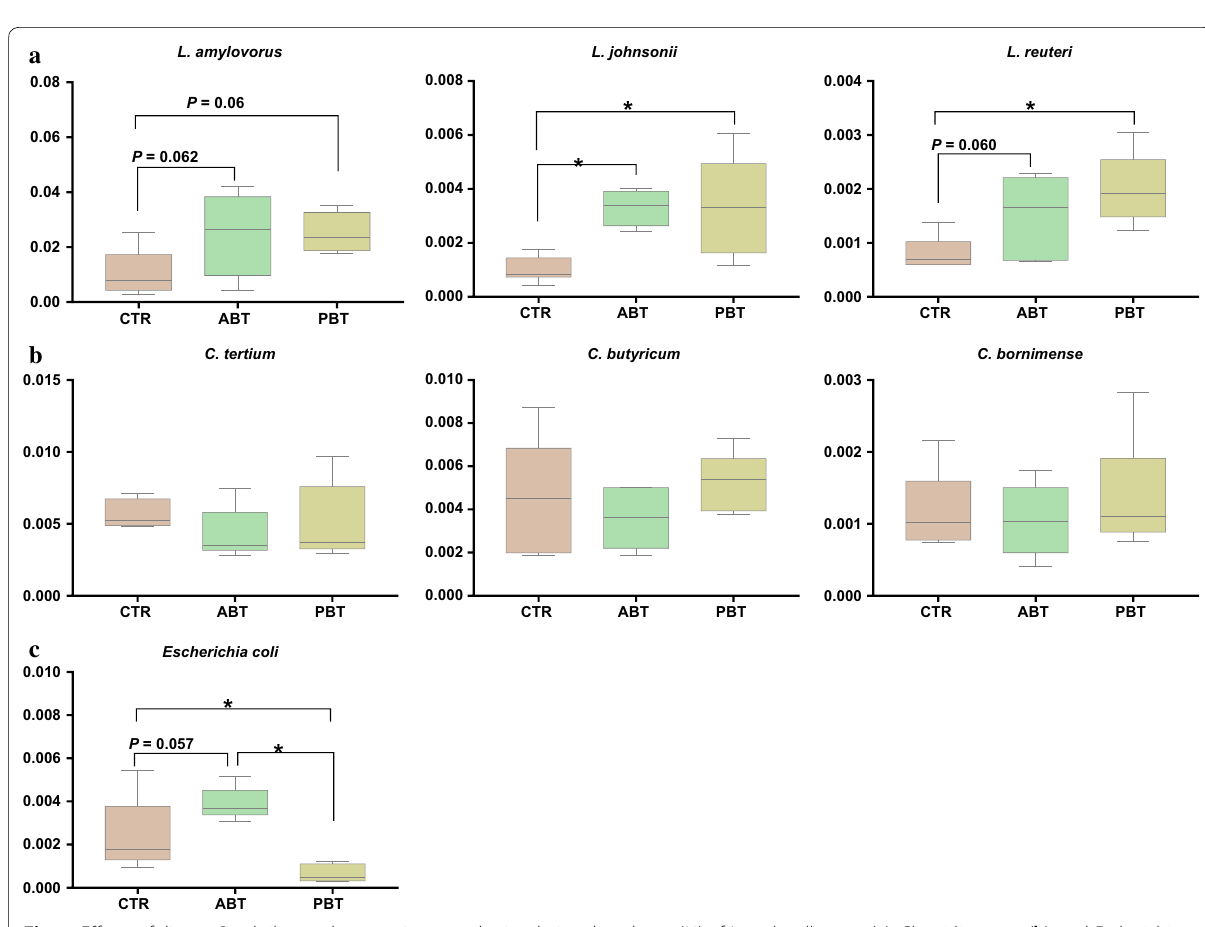
SEM. * Were considered to be significant when P < ±